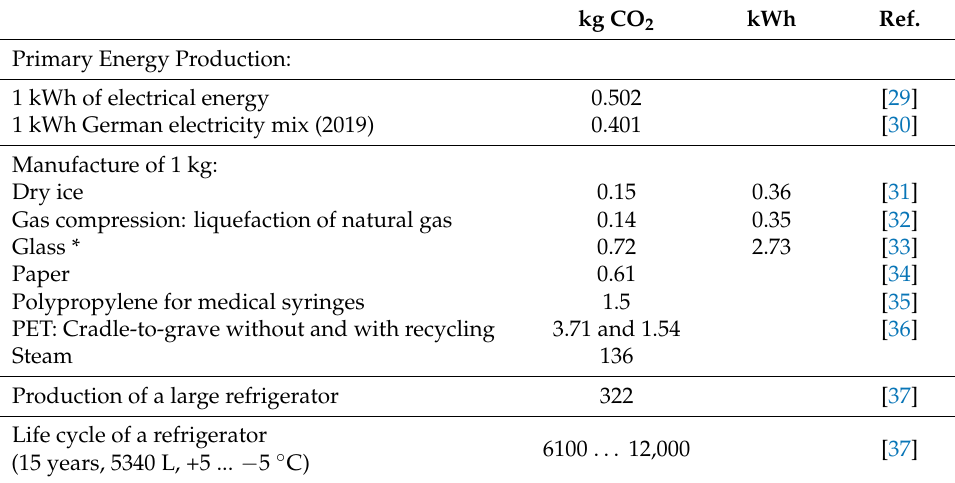
Table 1. Estimated CO 2 equivalents for production of electricity and goods.